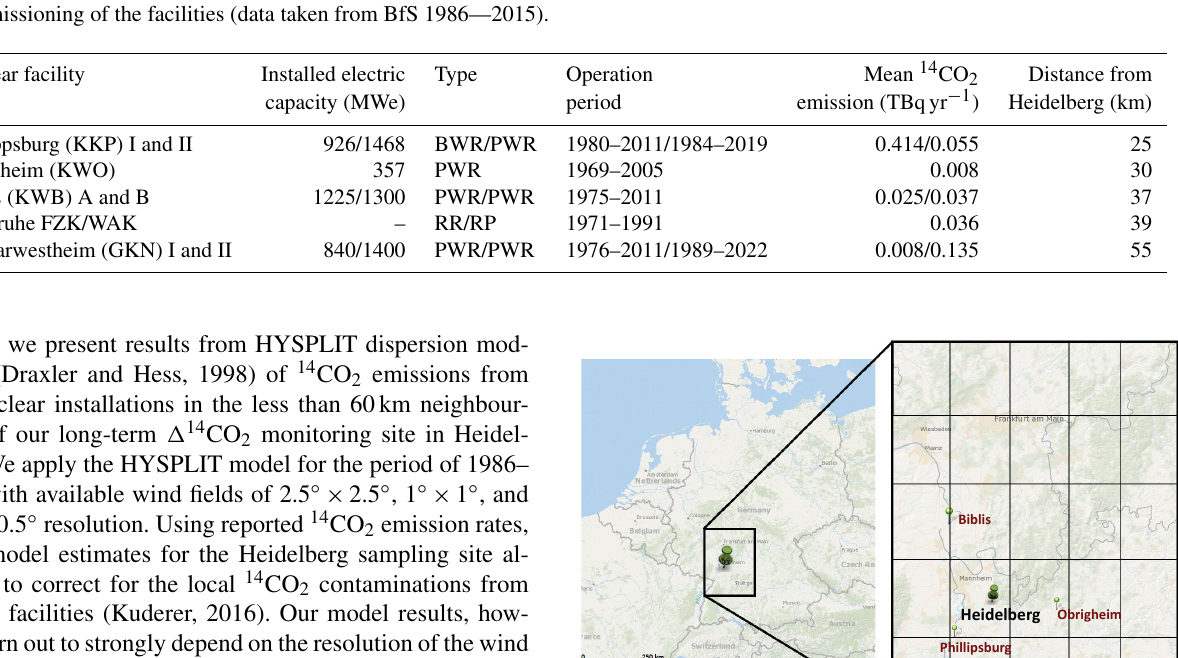
Table 1. Nuclear facilities in the surroundings of Heidelberg. Reactor type (BWR: boiling water reactor, PWR: pressurized water reactor), installed electrical power, and the average annual 14 CO 2 emissions during their respective periods of operation up to 2014, as well as the distance to the Heidelberg sampling site are given. Different reactor blocks are separated by a slash. RR are research reactors and RP is the research reprocessing plant (WAK) of the Karlsruhe Research Center (FZK). After the operation period, further emissions occur during the decommissioning of the facilities (data taken from BfS 1986—2015).